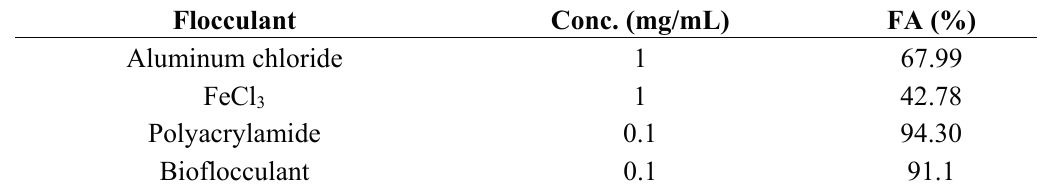
Table 2. Comparison of flocculating activity of MBF-UFH with conventional